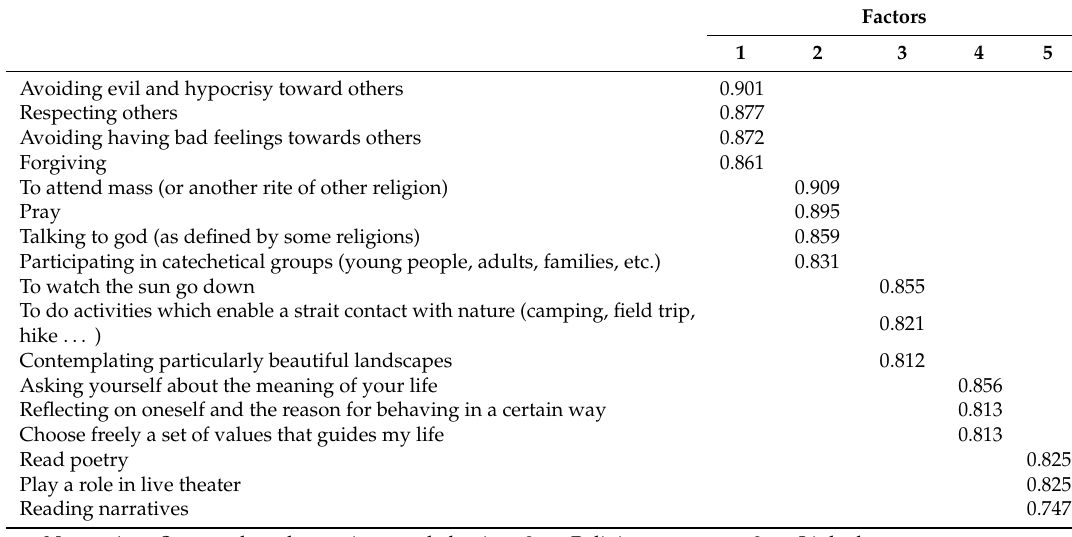
Table 2. Factor loadings results of the five-factor structure from confirmatory factor